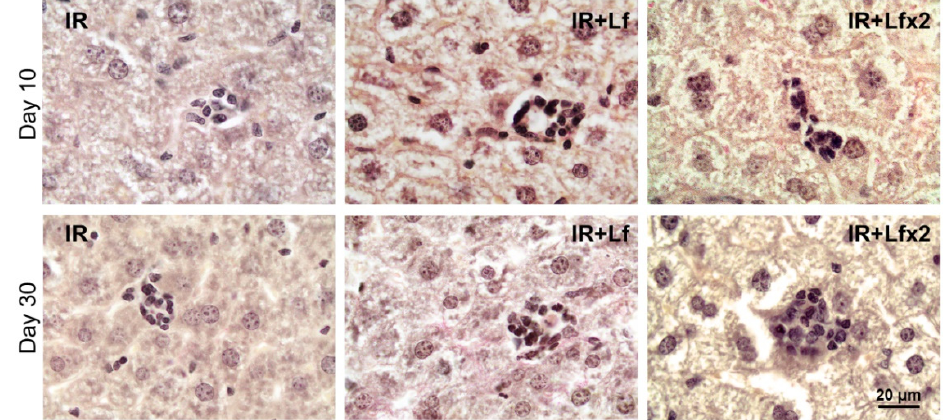
Figure 15. Lf promoted recovery of mononuclear cell clusters in the liver parenchyma of mice exposed to 7.5 Gy whole-body gamma irradiation. Representative photomicrographs of liver sections on days 10 (upper; n = 5–6 for each group) and 30 (bottom; n = 7–10 for each group) after irradiation. Groups: IR (irradiated), IR+Lf (Lf was administered immediately after irradiation; i.p.; 4 mg/mouse), IR+Lf×2 (Lf was administered twice: immediately after irradiation and 24 h after it). van Gieson staining. Scale bar = 20 μ m.